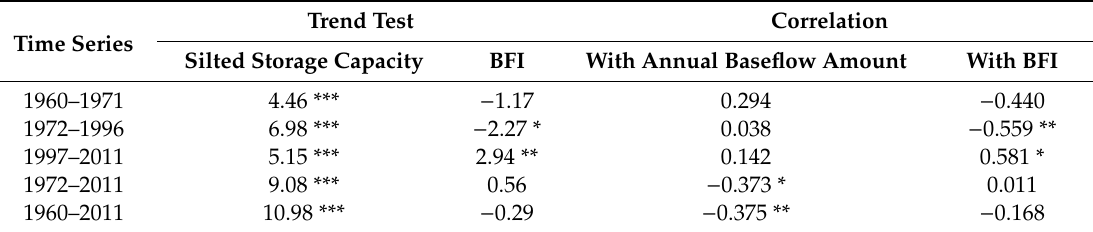
Table 5. Variation trend of silted storage capacity and its correlation with baseflow and base flow index (BFI) in Dali River Basin in di ff erent